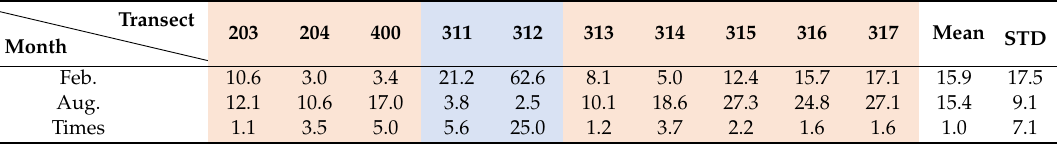
Table 3. The percent of TIL for the observation transect in February and August.